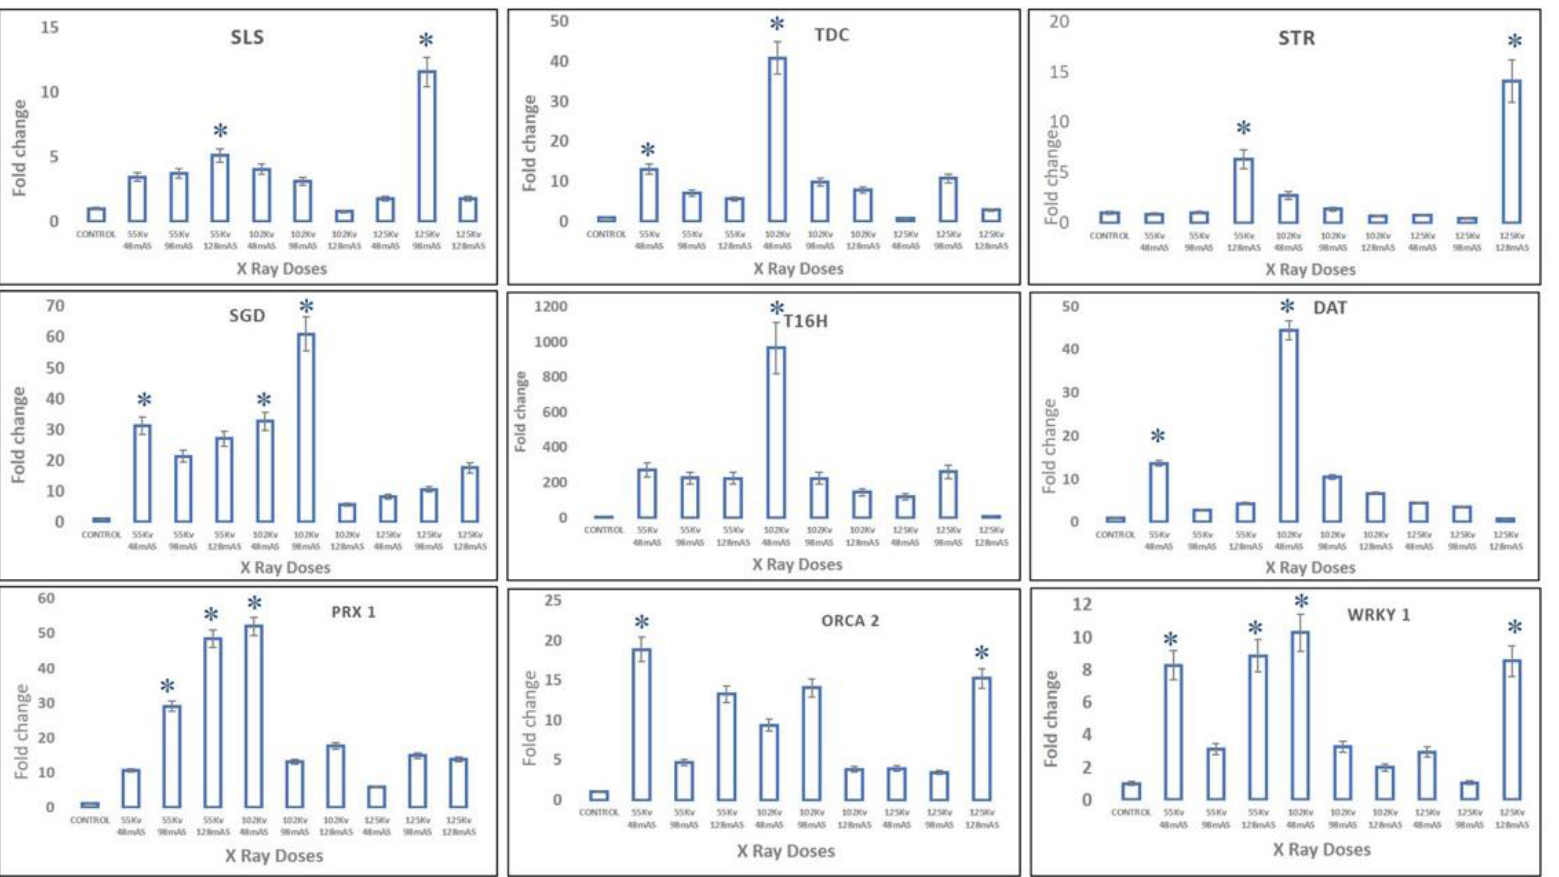
Figure 8. Real-time PCR quantification of the key MIA pathway genes in C. roseus in different X-ray-treated and control plants. The pathway genes are represented